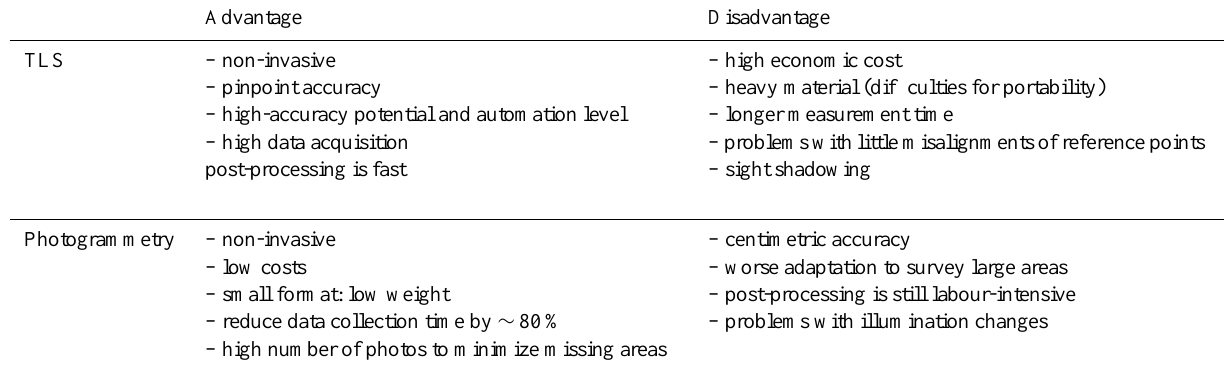
Table 5. Advantages and disadvantages of TLS and photogrammetry methodologies for studying geomorphological processes in badland